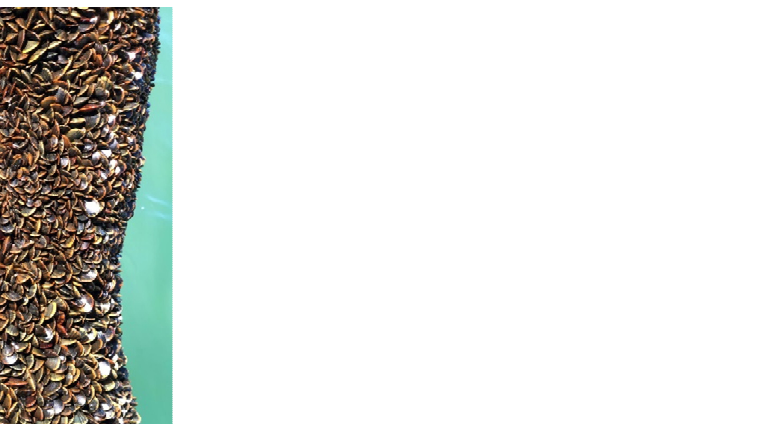
Figure 2. Juvenile Mussel’s colonization (6 months)—Aiguillon sur mer, France, 8 July 2020.